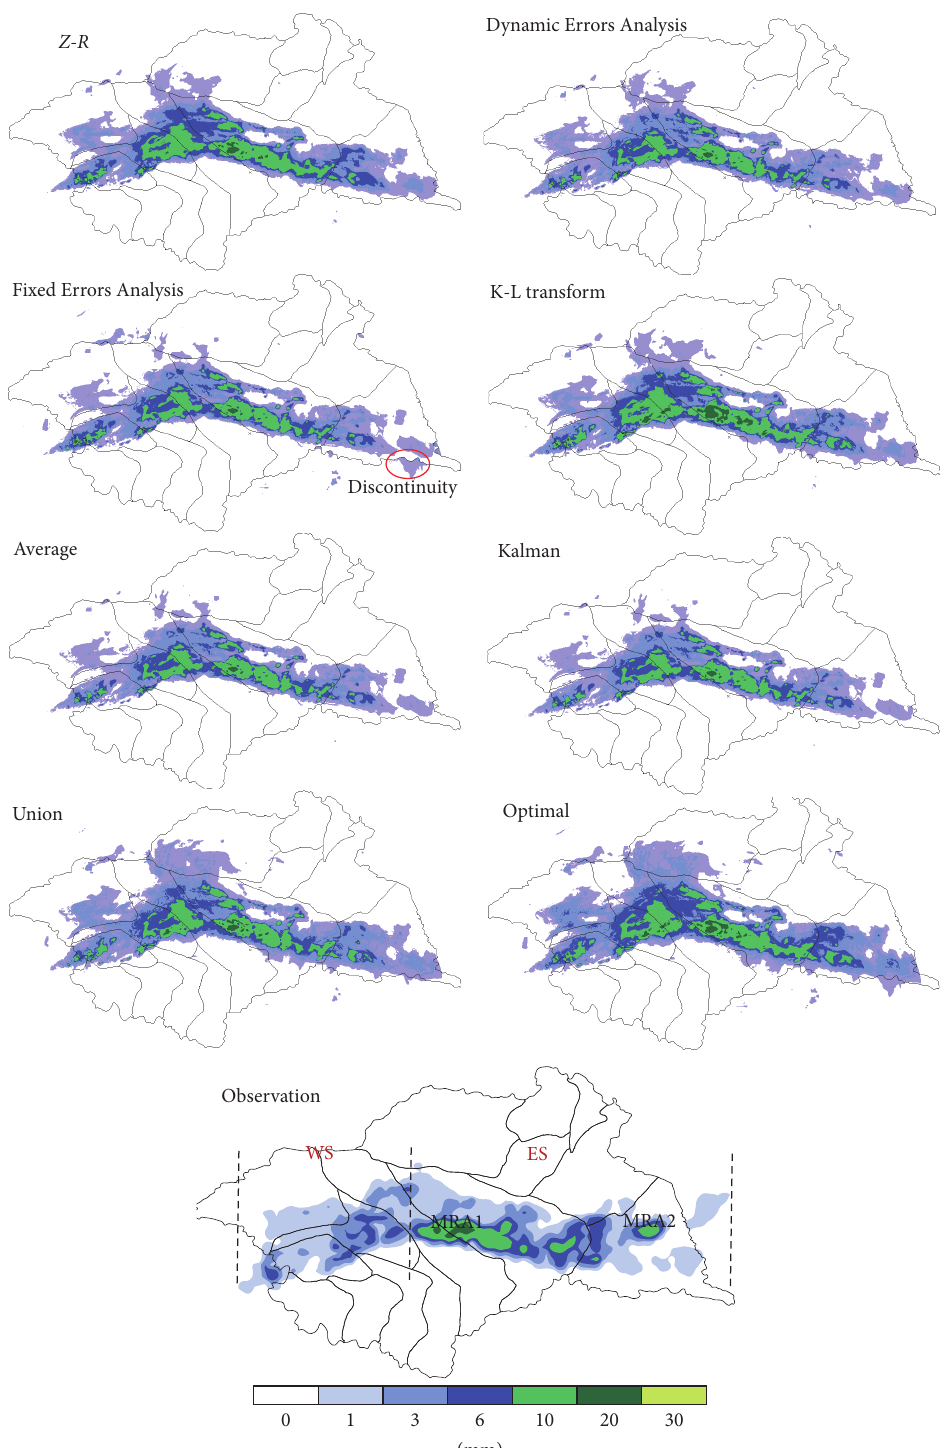
Figure 2: Rainfall distributions from 17:00 to 18:00 (UCT) July 5,